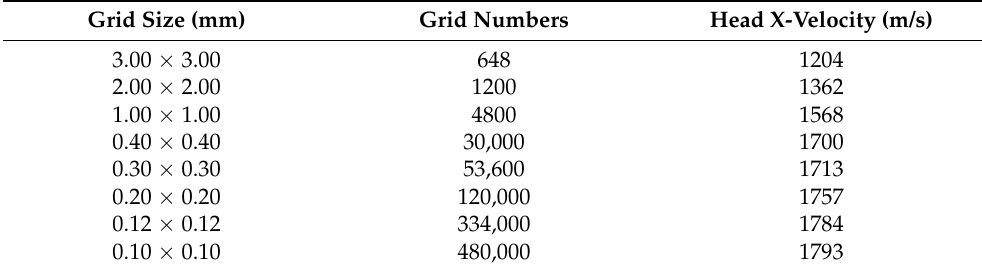
Figure 6. Head X-velocity of a projectile with different grid numbers.